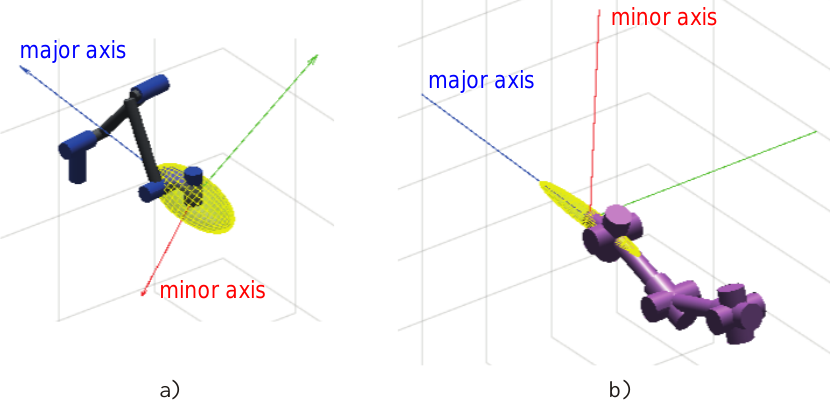
Figure 6. Velocity ellipsoids with axes orientation: ( a ) robotic arm, ( b ) human